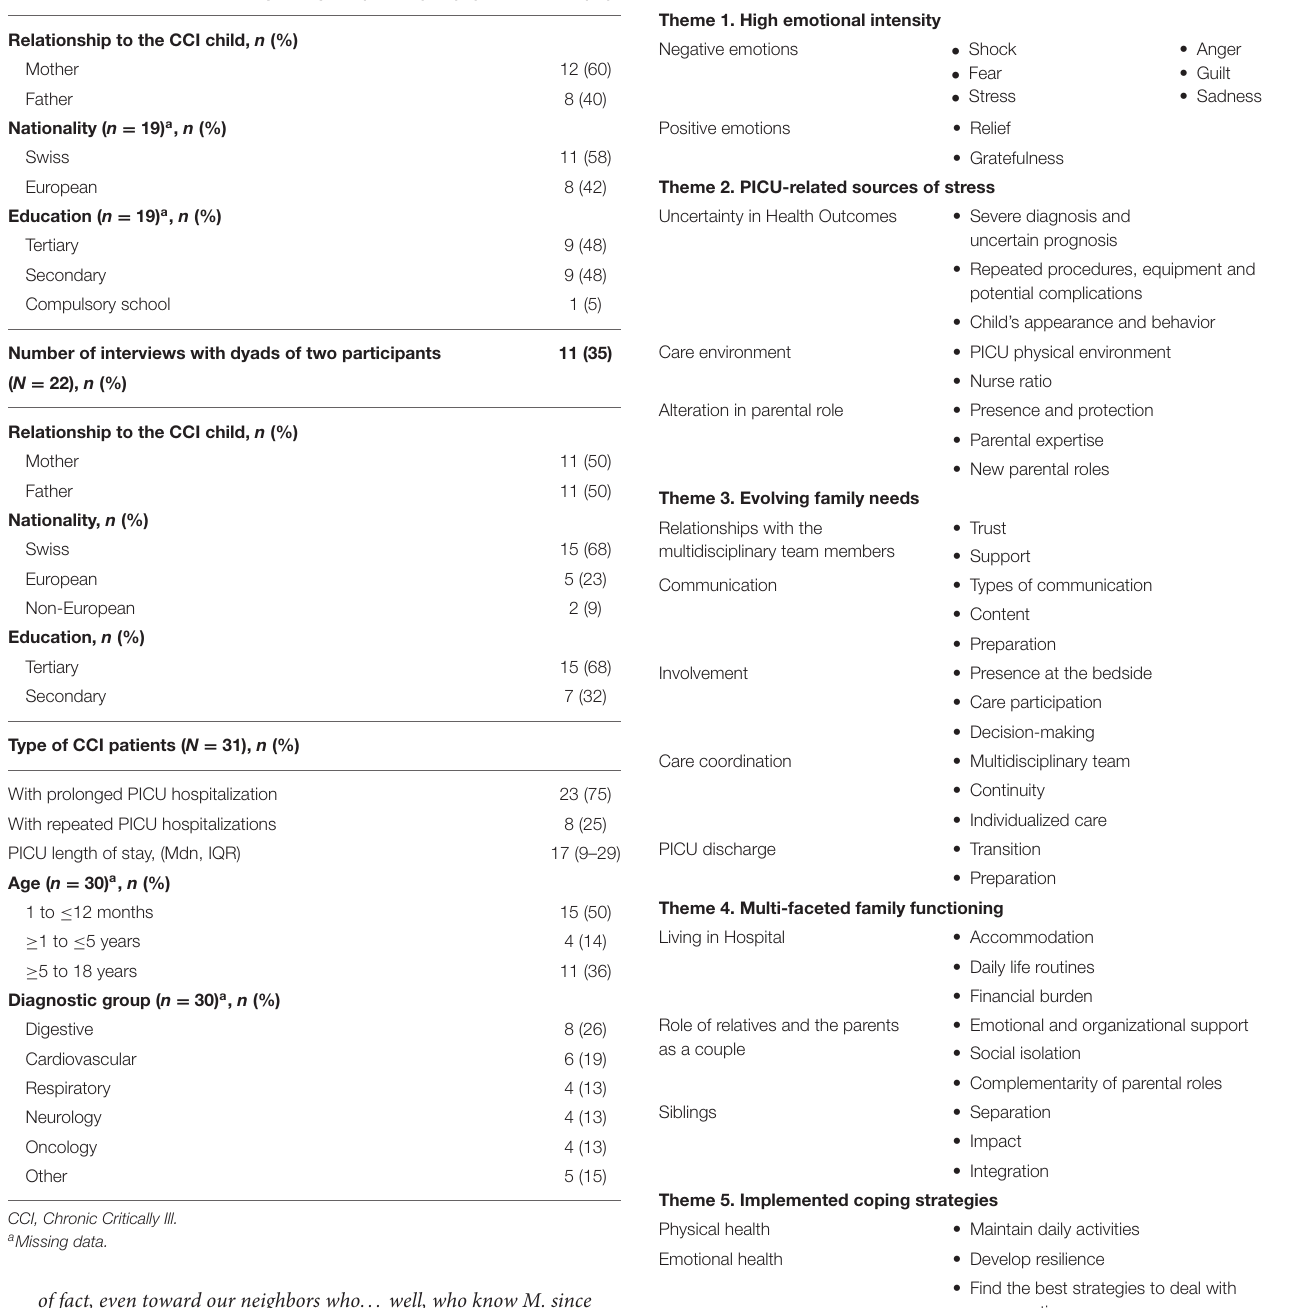
TABLE 1 | Demographic characteristics of the sample of participants and their CCI children. Number of interviews with one participant ( N = 20), n (%)